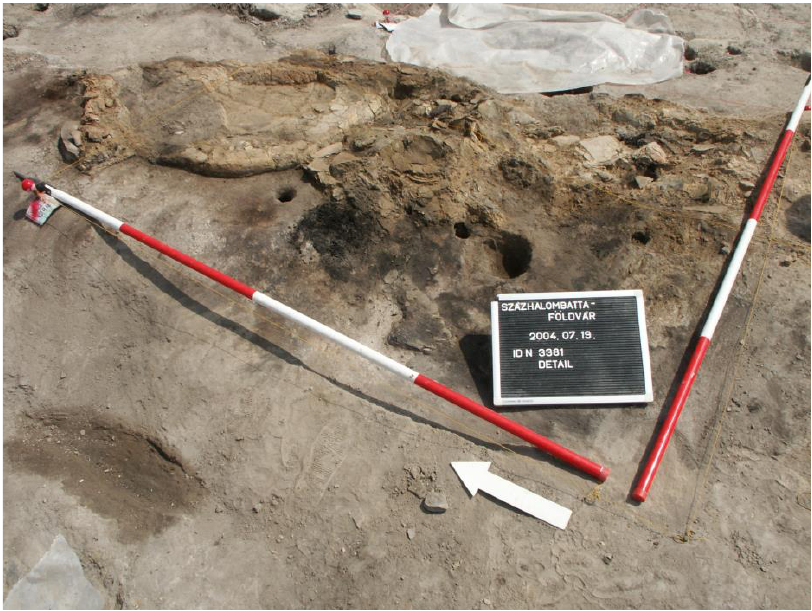
Figure 3. Basin-like clay feature (ID 3517) attached to the eastern wall of house ID